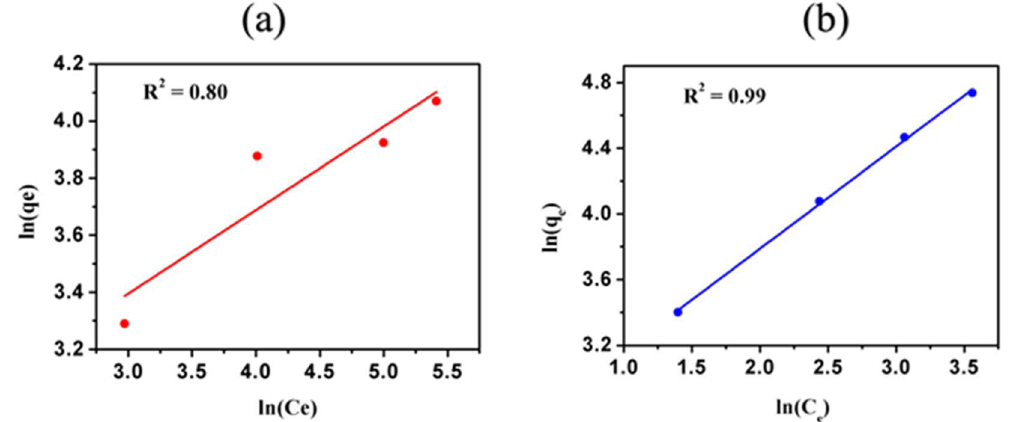
2 + and ( b ) Cd 2 + by hematite Figure 6. Freundlich isotherms of ( a ) Ni 2+ and ( b ) Cd 2+ by hematite nanoparticles. Figure 6. Freundlich isotherms of ( a ) Ni